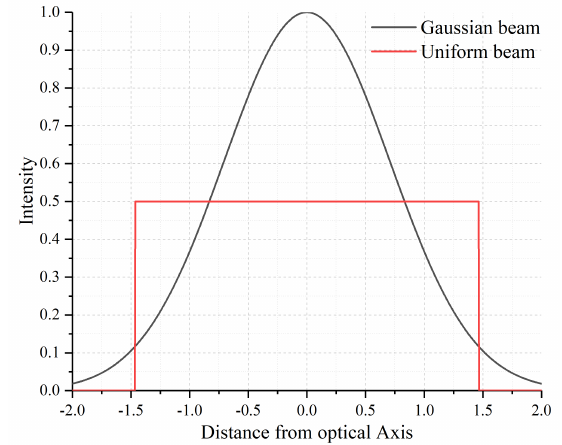
Figure 5. The beam intensity distribution of the Gaussian beam and uniform